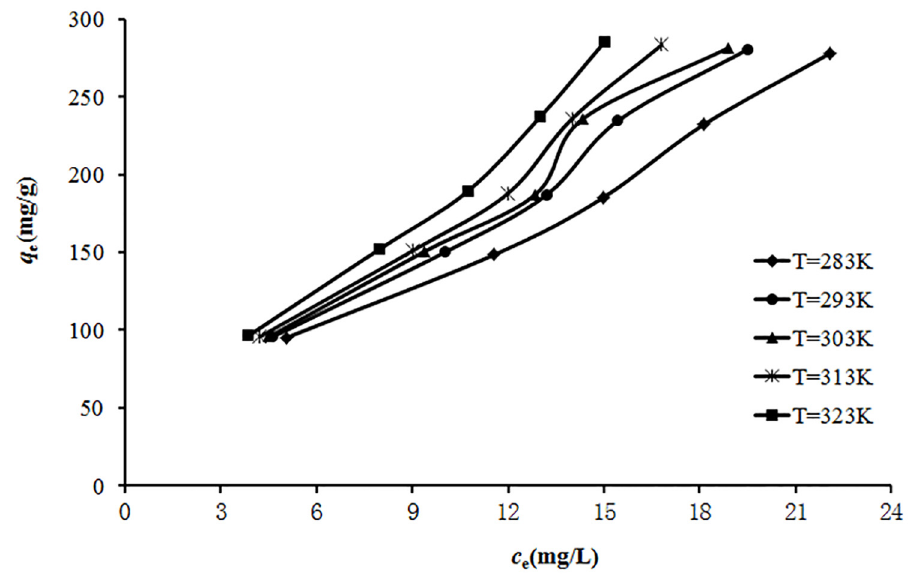
Fig 4. Adsorption isotherms of reserpine onto the SACEF at 283, 293, 303, 313 and 323 K. (experimental conditions: pH = 5, c 0 = 100~300 mg/L and absorbent dosage =